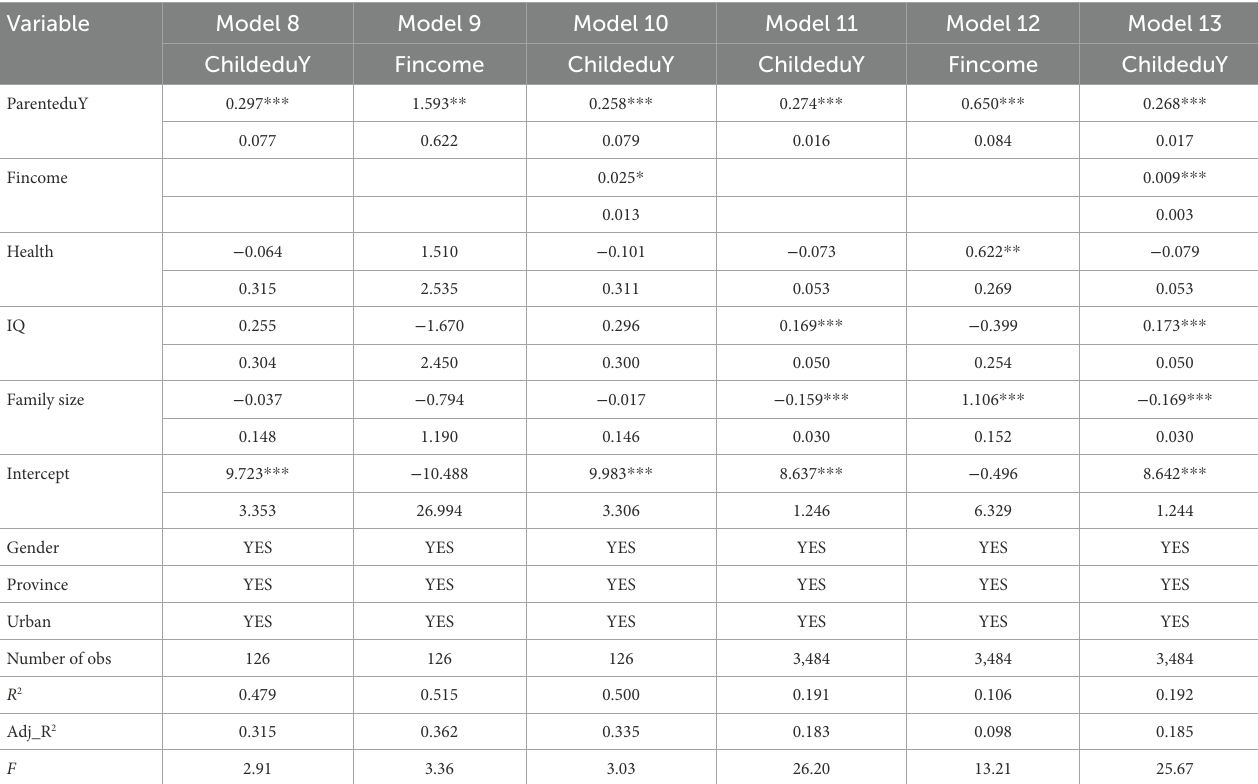
TABLE 7 Results of the mediating effect of college expansion on household